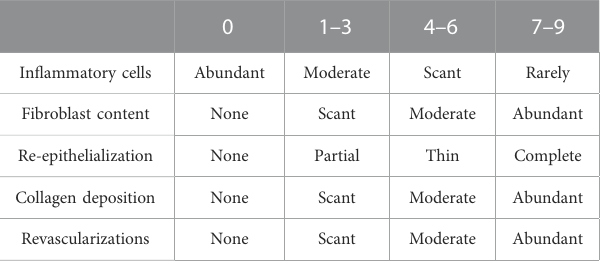
TABLE 5 Histological evaluation of wound tissue in all groups by H&E